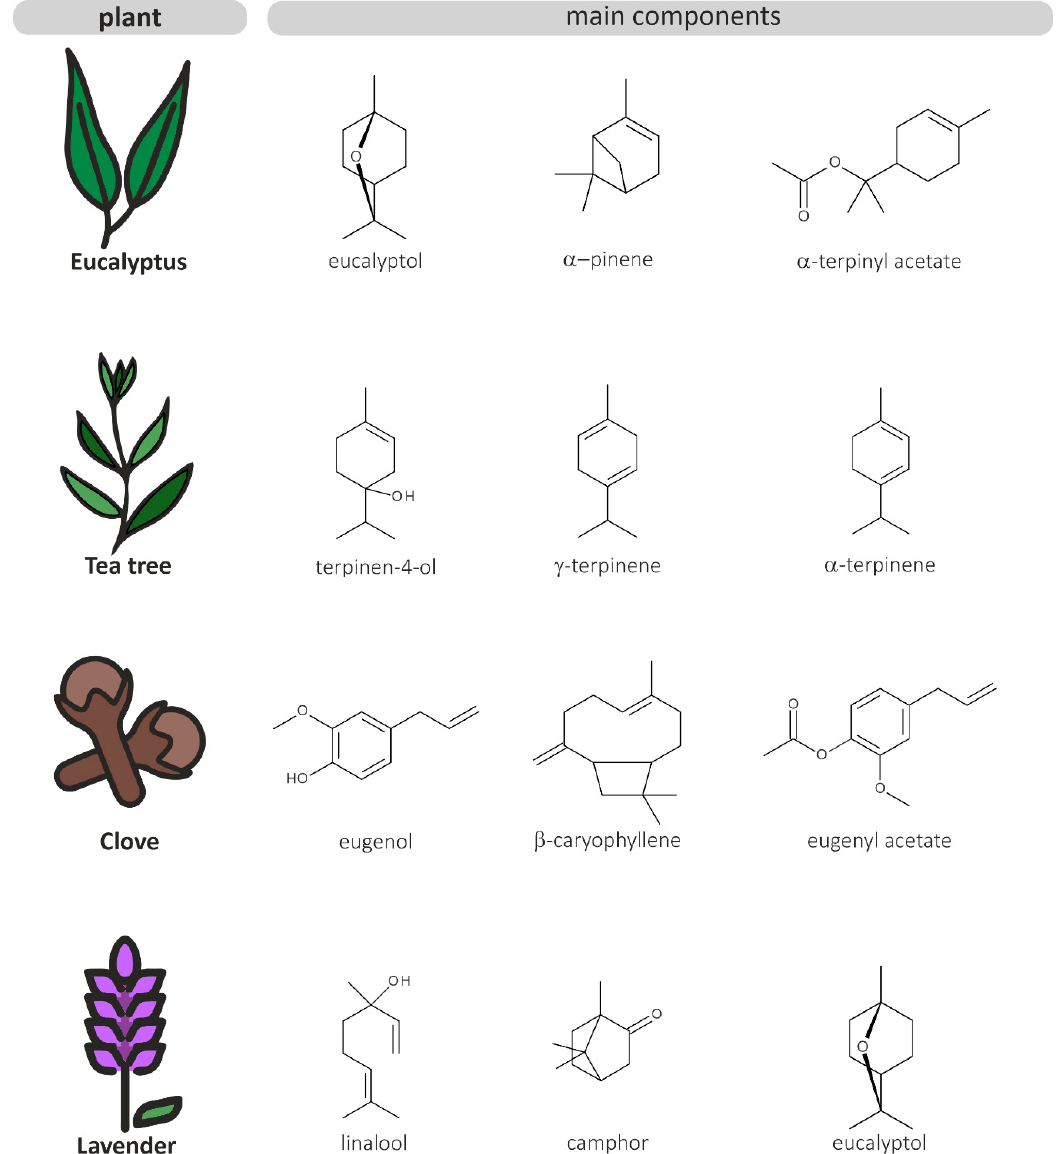
Figure 2. Chemical structures of the main components of the four selected EOs.